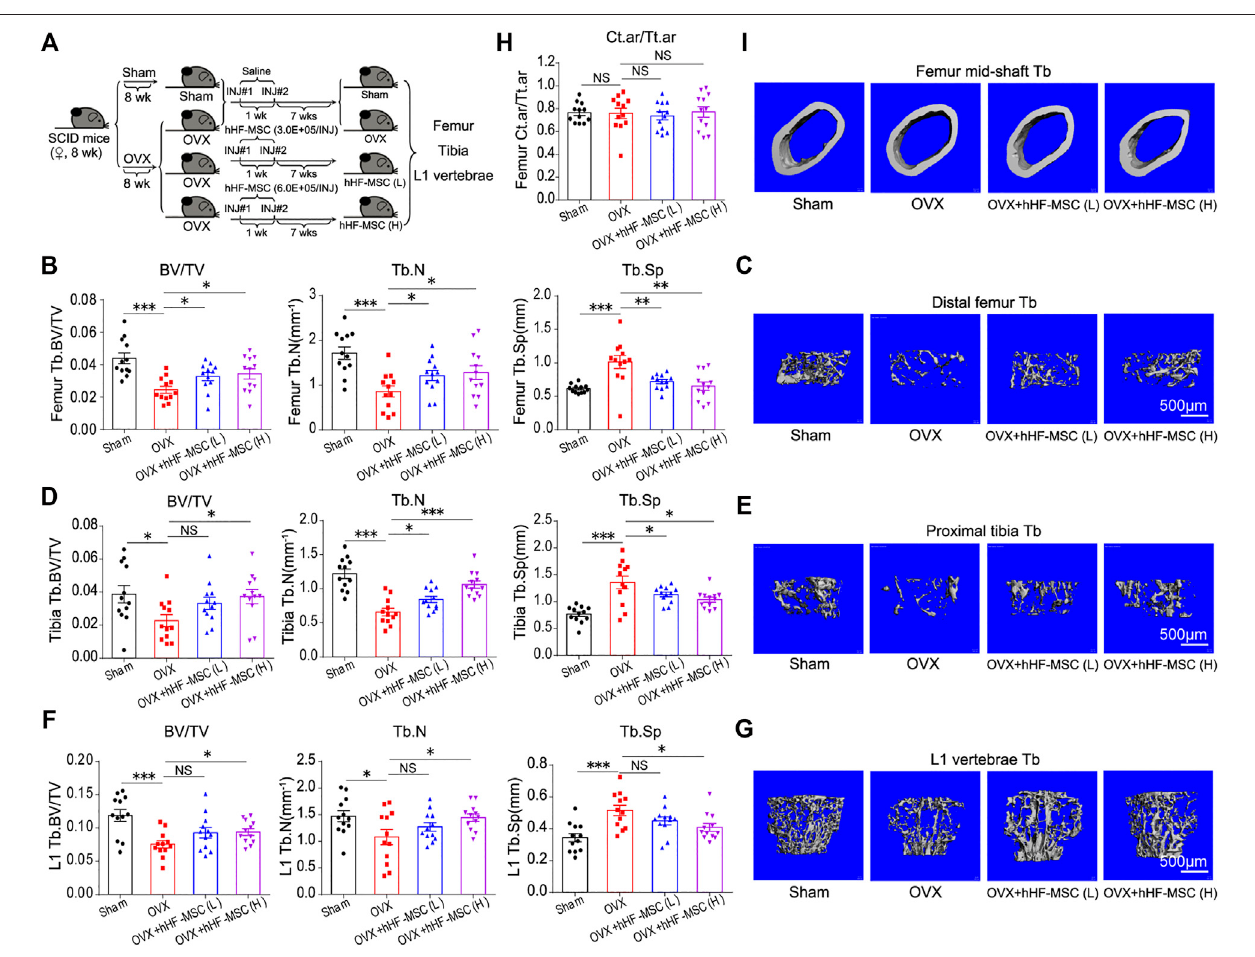
FIGURE 4 | Intravenous transplantation of hHF-MSCs yields better recovery of trabecular bone mass and microstructure in OVX-induced osteoporotic mice. (A) Experimentalgroupingandtimeline.OVX-induced osteoporosisinSCIDmicewasallowedtodevelopfor8 weeksbeforethe fi rsthHF-MSCsinjection. ThesecondhHF- MSCs injection was given at week 1 after the initial injection. Mice were sacri fi ced and samples were collected at week 7 after the second injection. (B) Bone volume fraction (BV/TV), trabecular bone number (Tb.N), and trabecular bone space (Tb.Sp) of distal femur of mice in response to hHF-MSCs transplantation determined bymicro-CT( n =12foreachgroup). (C) Representative3Dreconstructionimagesofdistalfemurtrabecularbone. (D) BV/TV,Tb.N,andTb.Spofproximaltibiaofmicein responsetohHF-MSCstransplantationdeterminedbymicro-CT.( n =12foreachgroup). (E) Representative3Dreconstructionimagesofproximaltibiatrabecularbone. (F) BV/TV, Tb.N, and Tb.Sp of L1 vertebrae of mice in response to hHF-MSCs transplantation determined by micro-CT. ( n = 12 for each group). (G) Representative 3D reconstruction images of L1 vertebrae trabecular bone. (H) Ct.ar/Tt.ar (the ratio of cortical bone area to total area) of mice in response to hHF-MSCs transplantation determined by micro-CT. ( n = 12 for each group). (I) Representative 3D reconstruction images of cortical bone of femur mid-shaft. All the data were obtained from three independent experiments. Data were shown as the means ± s.e.m. *: p < 0.05, **: p < 0.01, ***: p < 0.001, NS: not signi fi cant.